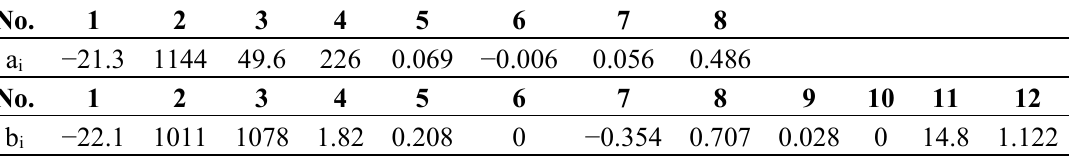
Table 2. Fitting coefficients of the Magic